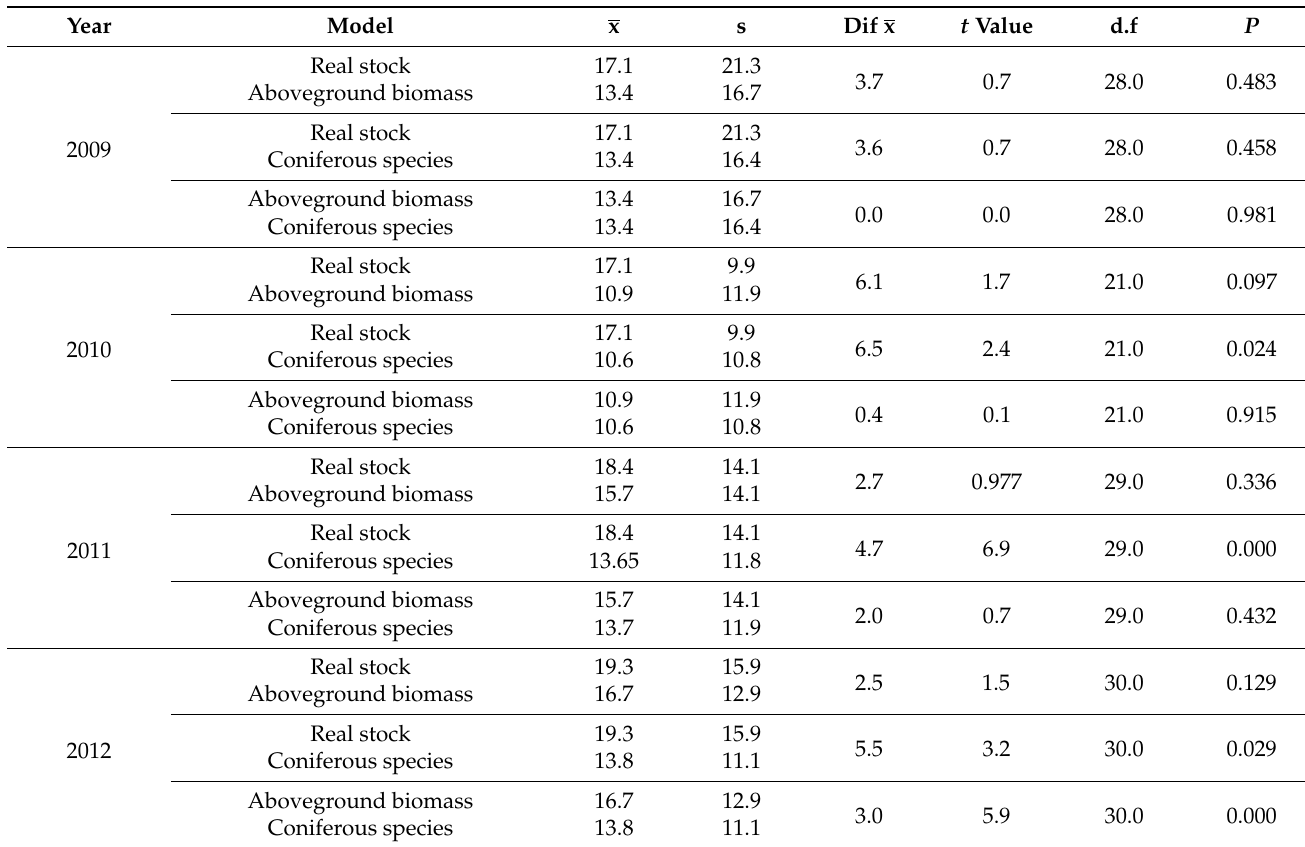
Table 3. Comparison of fuel load prediction models by